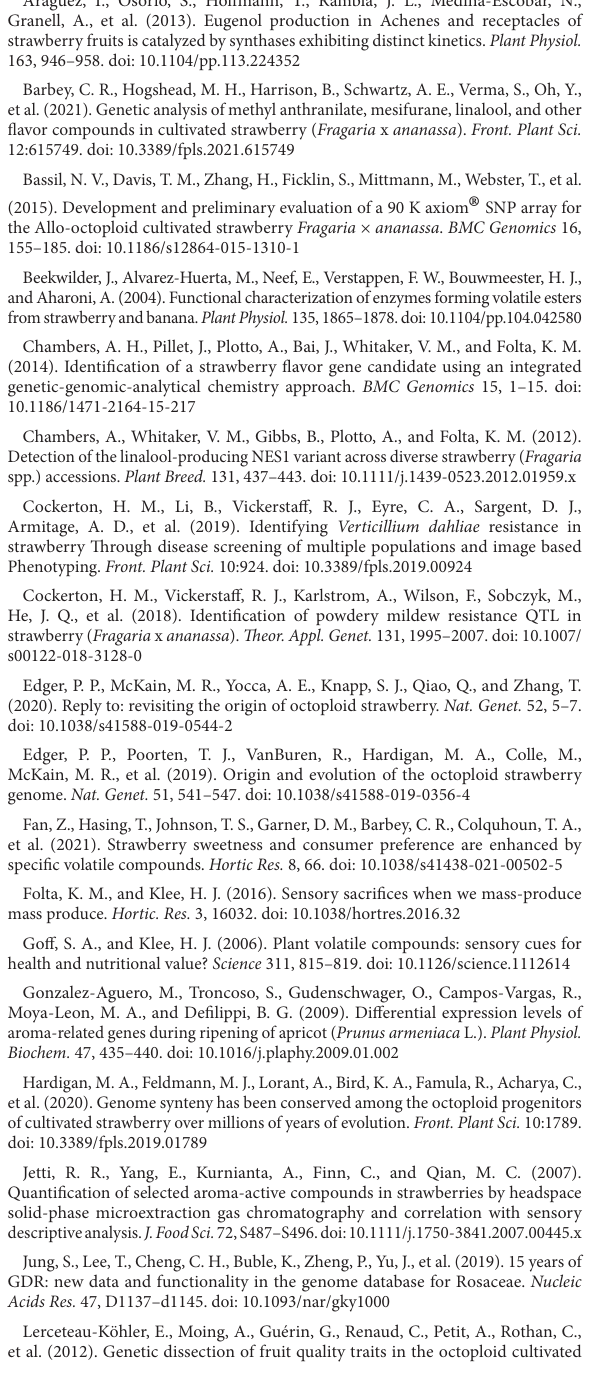
marker for “FC50 × FD54” and “21AF” population. Left: red boxes cover 1-LOD confidence intervals and red line is the Affx-88845940 position. Marker class represented as codominant (green), “FC50”